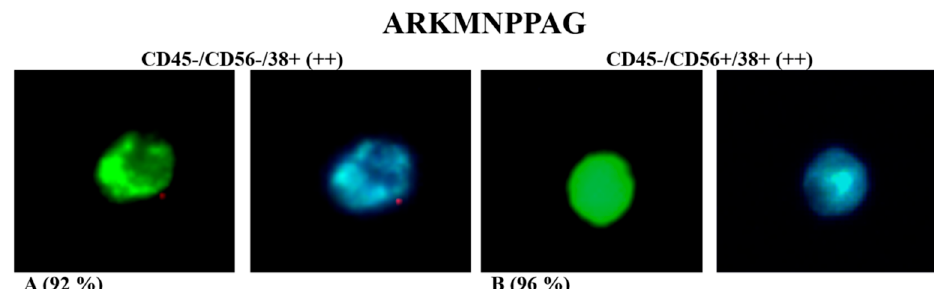
Figure 2. Ex-vivo fluorescence test of ARKMNPPAG FITC-labelled phage incubated with immunophenotypes CD45 − /CD56 − /CD38 + ( A ) and CD45 − /CD56 + /CD38 + ( B ). Green fluorescence was due to FITC-labelled phage, while blue fluorescence was due to DAPI nucleus staining (magnification 100 × ). Percentage in brackets refers to only cells with evident green fluorescence due to phage clone binding.